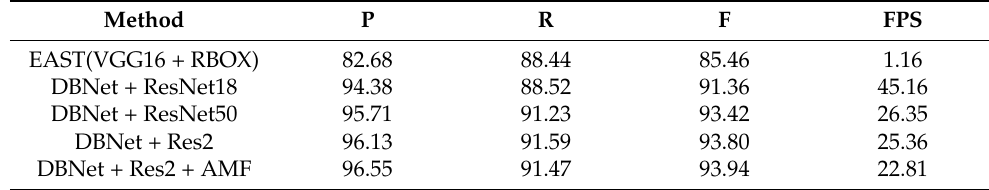
Table 4. The results of text detection on Uyghur